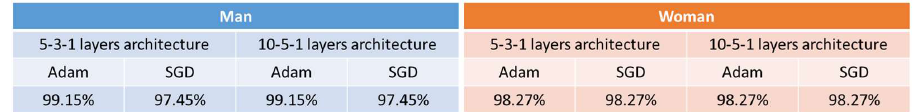
Figure 9. Pipeline for creating each user’s classifier and example of data augmentation.